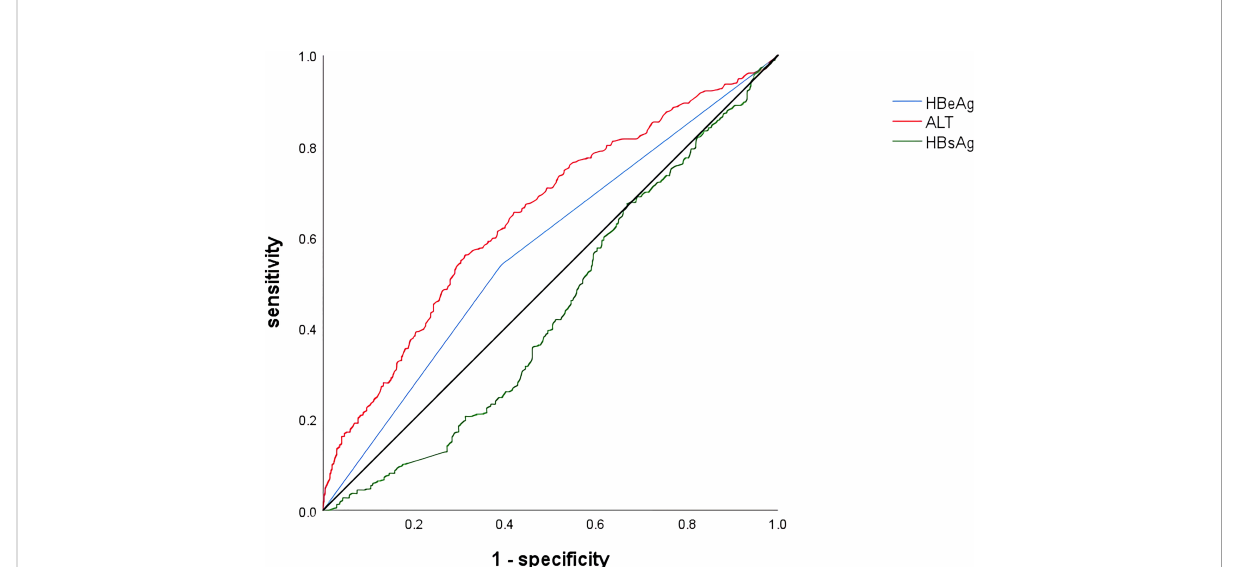
FIGURE 2 Receiver operating characteristic curve of variables associated with signi fi cant hepatic histopathology. HBeAg, hepatitis B e antigen; ALT, alanine aminotransferase; HBsAg, hepatitis B surface